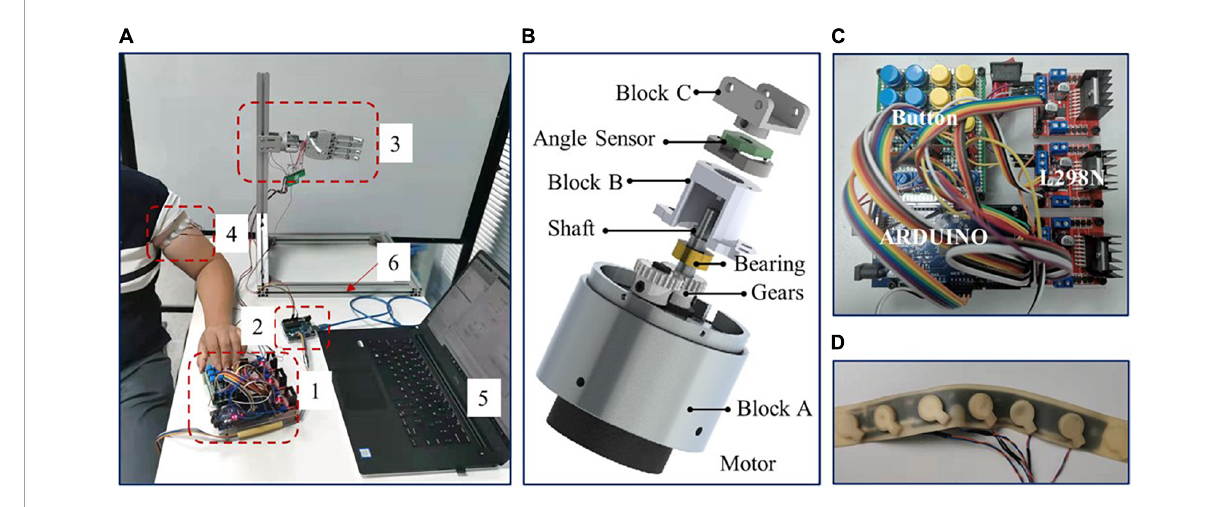
FIGURE4 (A) The devices of vibrotactile perception range test, (B) the prosthetic wrist, (C) button control module, and (D) vibrotactile armband.